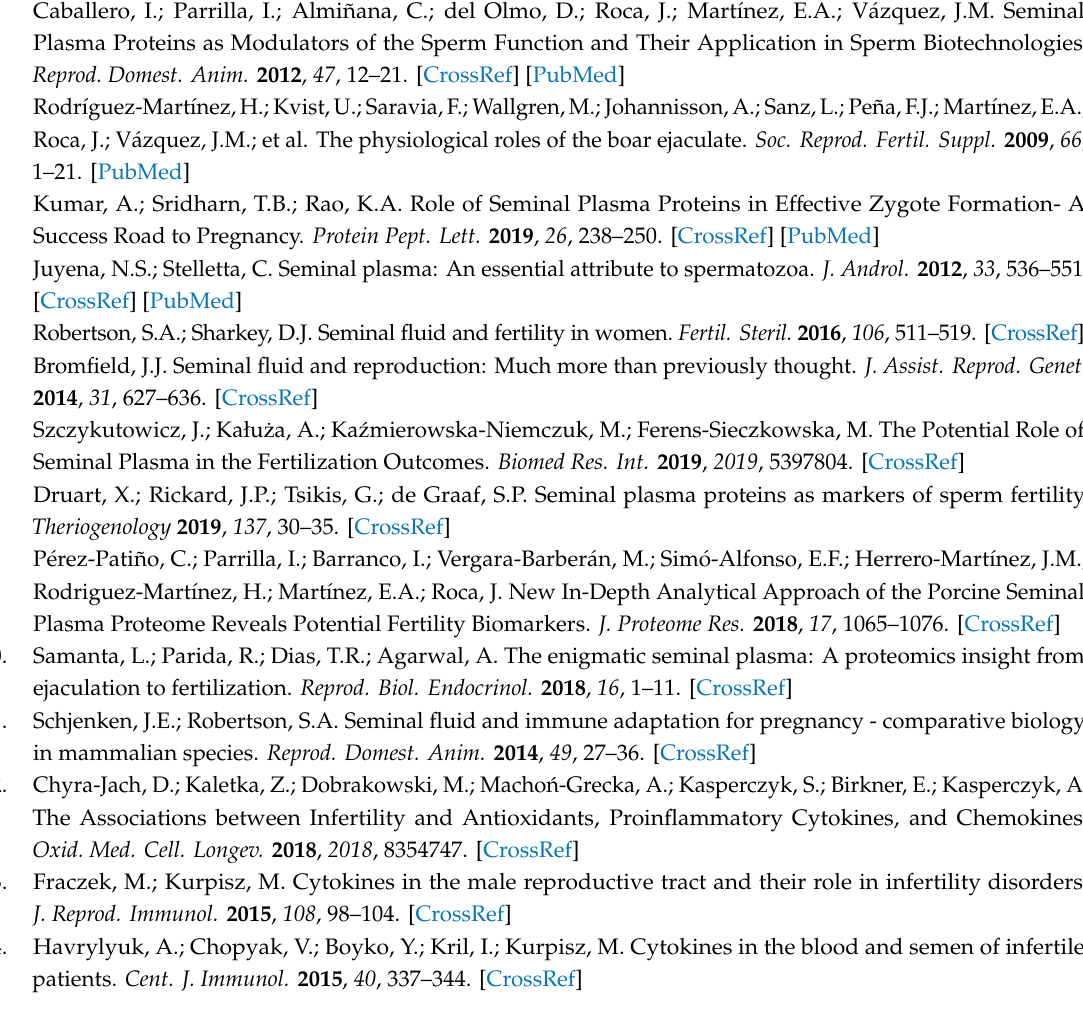
Table S1: Concentration of cytokines (pg / mL; mean ± SEM) in seminal plasma of ejaculates (n: 180) collected in nine boars (20 ejaculates per boar) during periods of increasing (I, January to June) and decreasing ambient daylength and air temperature (D, July to December). Table S2: Total amount of cytokines (ng / mL; mean ± SEM) in seminal plasma of ejaculates (n: 180) collected in nine boars (20 ejaculates per boar) during the periods of increasing (I, January to June) and decreasing ambient daylength and air temperature (D, July to December). Table S3: Relationship between seminal plasma cytokines and ejaculate